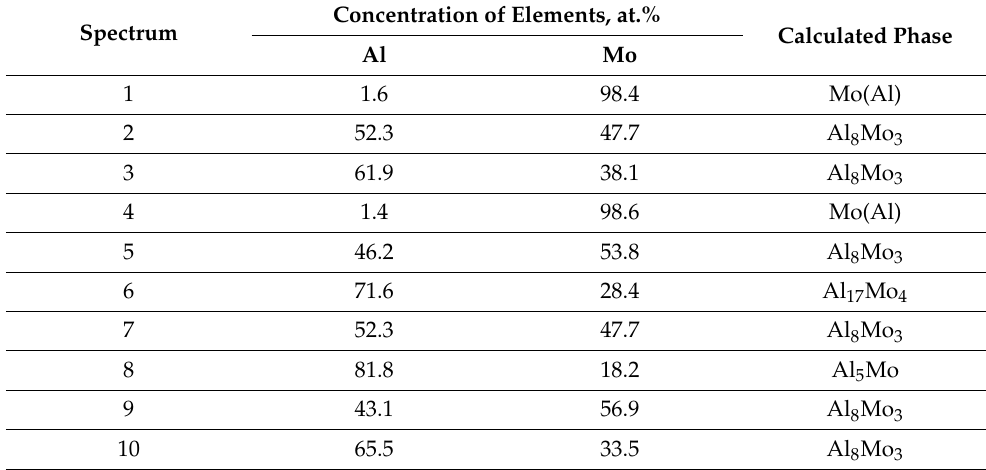
Table 6. EDS analysis of the AA5154/Mo with 1.2 g/layer was obtained by using SEM (Figure 11e,f). Concentration of Elements, at.% Spectrum